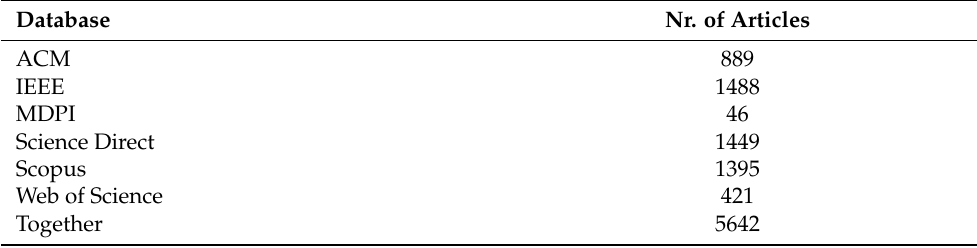
Table 2. Articles retrieved from the selected digital libraries using the specified search string.